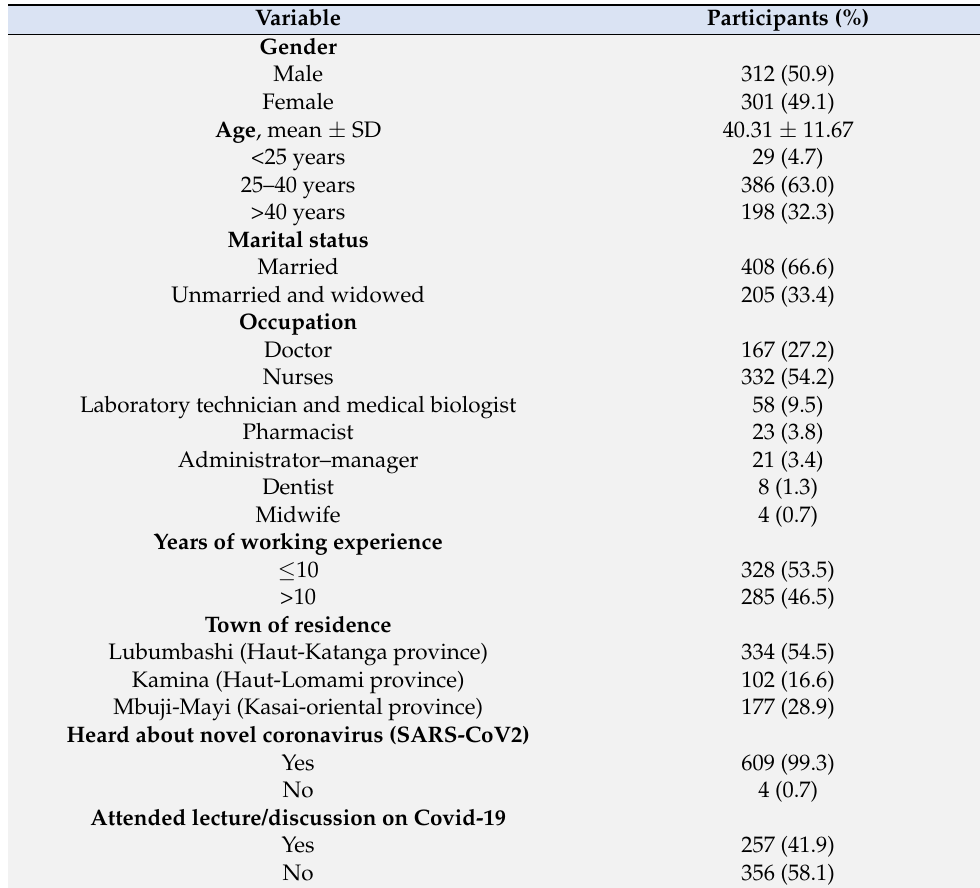
Table 1. Characteristics of the respondents (N =